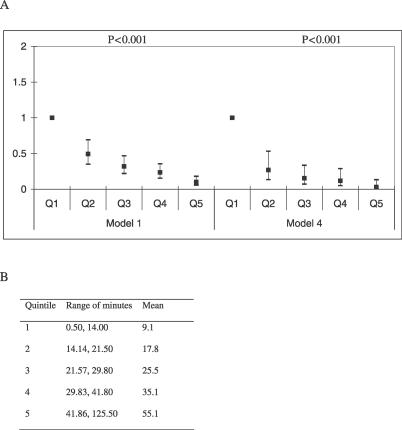
Adjusted Odds Ratios for Obesity by Quintiles of Objectively Measured Minutes of Moderate and Vigorous Activity in 2,622 12-Year-Old Boys from ALSPAC(A) Model 1 gives the odds ratios from the minimally adjusted model, i.e., obesity (adjusted for age, height, and height squared) regressed on quintiles of MVPA.Model 4 gives the odds ratios from the maximally adjusted model, i.e., obesity (adjusted for age, height, and height squared) regressed on quintiles of MVPA, maternal education, lowest social class, birthweight, gestational age, smoking in pregnancy, obesity of mother, sleep pattern, TV viewing, and pubertal stage.(B) Mean and ranges of quintiles of minutes of moderate and vigorous activity for boys.